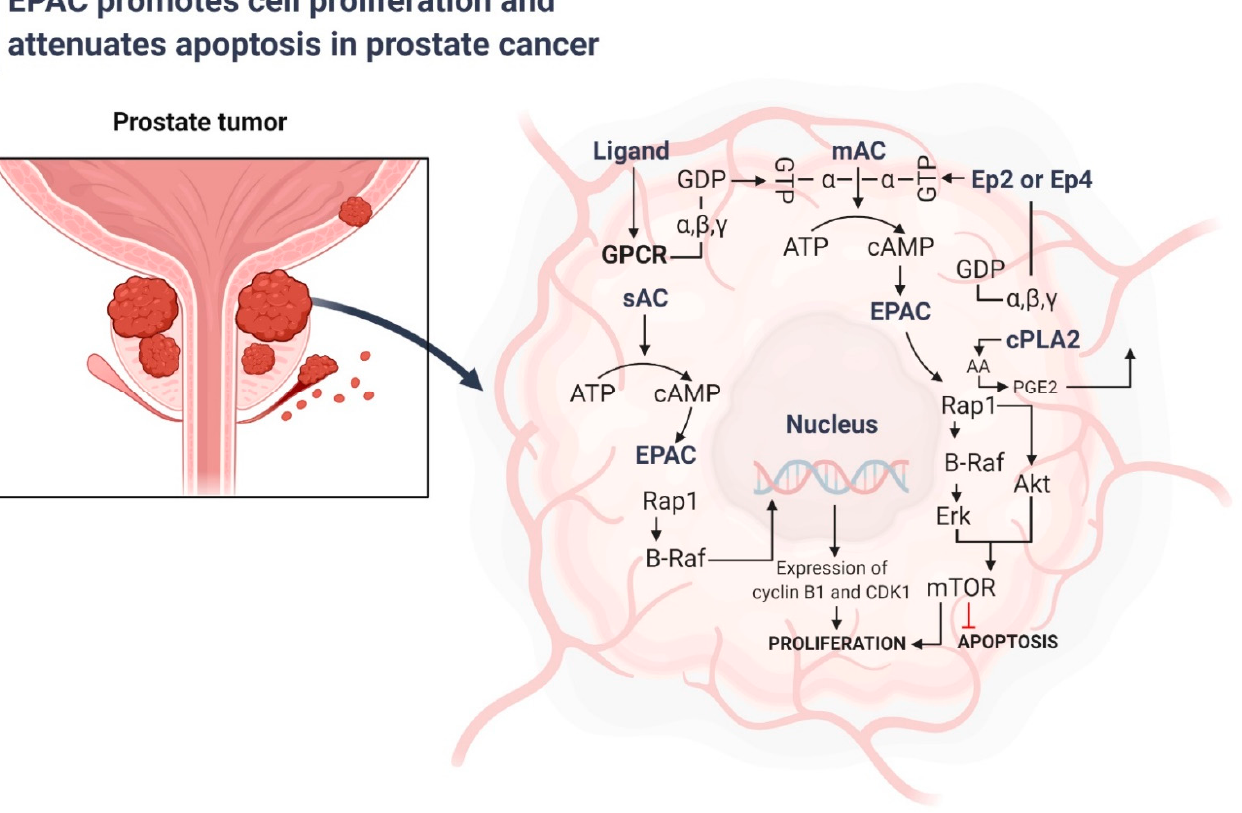
Figure 4. EPAC stimulates cell growth and inhibits apoptosis in prostate cancer . When sAC is turned on, it makes cAMP, which turns on EPAC, which is the soluble form of type 10 adenylyl cyclase. EPAC helps B-Raf, which then activates the expression of CDK1 and cyclin B1 in a way that depends on Rap1. These proteins help the cell cycle move from the G2 phase to the M phase. When mAC is turned on, EPAC is turned on, which causes cAMP to be made. The B-Raf/ERK and Akt pathways, which lead to mTOR, may then be turned on by EPAC. When mTOR is turned on, it helps cells grow and prevents them from dying. EPAC is anti-inflammatory, which makes these benefits even better. cPLA2 is turned on when MAPK is stimulated by EPAC. COX-2 changes phospholipids in the membrane into AA to make PGE2. PGE2 is made by prostate cancer cells and can move into the microenvironment of the tumor, where it can activate EP2 and EP4 receptors on target cells and cells close by. The mAC is also turned on by G proteins, which bind to the cAMP and EP4 receptors and cause these two molecules to build up. sAC, the soluble type 10 adenylyl cyclase; AA, arachidonic acid; COX-2, cyclooxygenase-2; cPLA2 cytosolic phospholipase A2; B-raf, Serine/threonine-protein kinase B-raf; EPAC, exchange protein directly activated by cAMP; EP2, PGE2 receptor 2; EP4, PGE2 receptor 4; mAC, membrane-bound adenylyl cyclase; PGE2, prostaglandin E2.